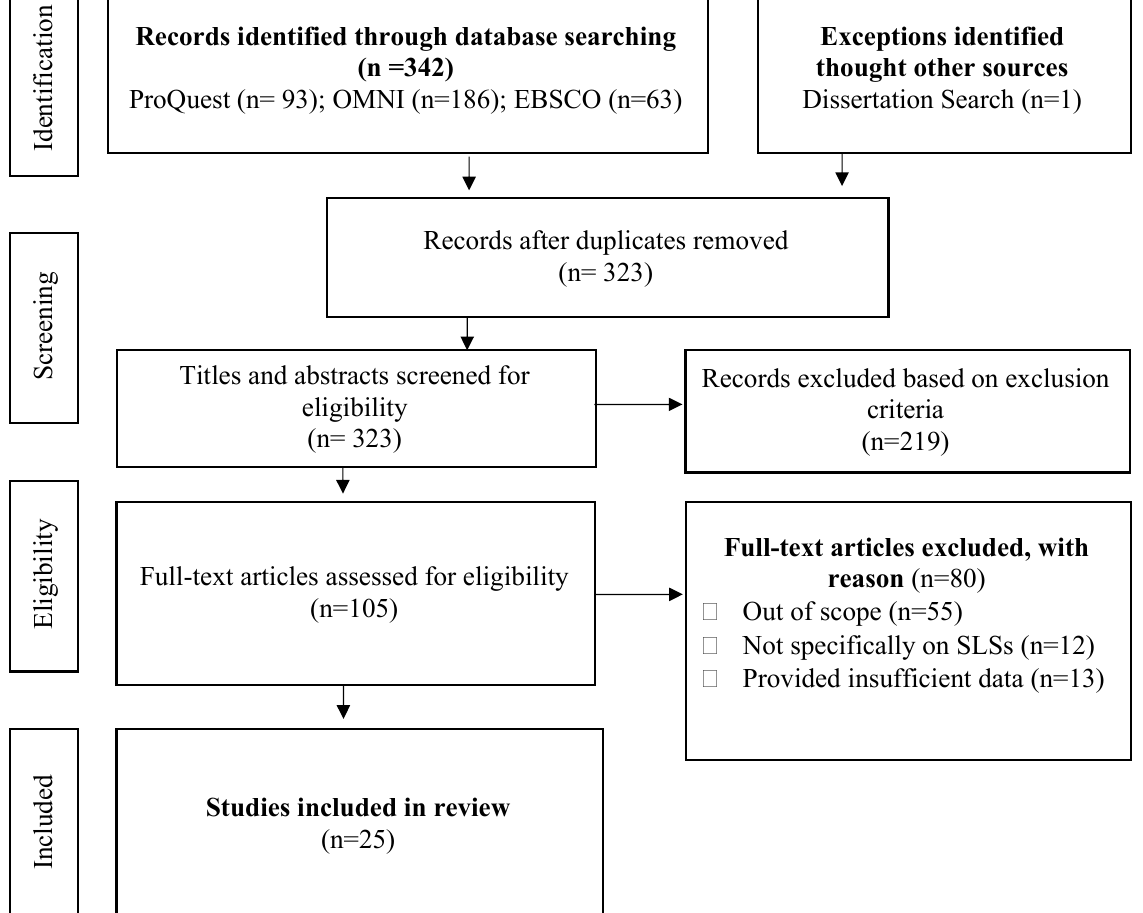
Figure 1. PRISMA flow chart of the study selection process.